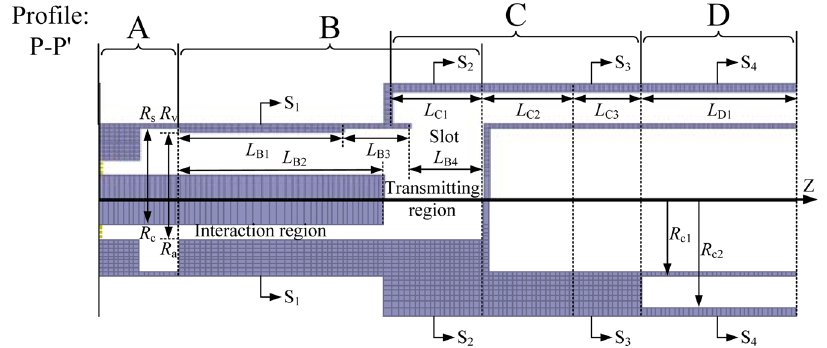
Figure 1. Schematic diagram of the longitudinal profile of the RM.